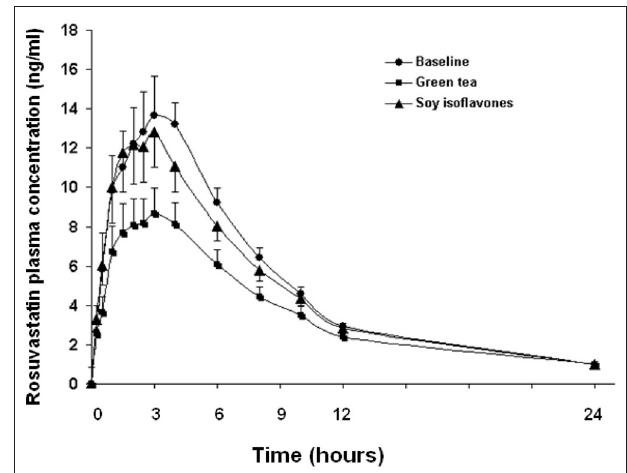
FIGURE 1 | Effects of green tea extract and soy isoflavones on the pharmacokinetics of rosuvastatin in 20 healthy subjects. Data are arithmetic mean ( ± SD).